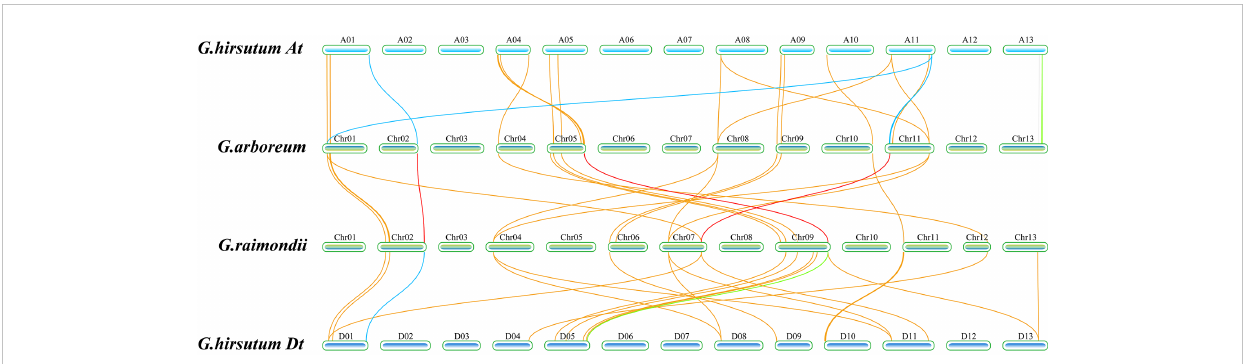
FIGURE 3 Schematic diagram of collinear analysis of the TPS family genes of G. hirsutum A/D subgroup and G. arboreum and G. raimondii , respectively. The blue squares represented the chromosome of G. hirsutum , the At subgroup of G. hirsutum was at the top, and the Dt subgroup of G. hirsutum was at the bottom. In the fi gure, the green squares represented the chromosomes of G. arboreum and G. raimondii , and the length represents the length of the chromosome. The name of the chromosome was labeled above each chromosome. The lines in the fi gure represented collinear relationships between species. The yellow lines represented collinear relationships between G. hirsutum and both G. arboreum and G. raimondii , the red lines represented collinear relationships of GhCDNs between G. arboreum and G. raimondii , the blue lines represented collinear relationships of 12 GhCDN-A between G. hirsutum and both G.arboreum and G. raimondii , the green lines represented collinear relationships of other GhCDNs between G. hirsutum and both G.arboreum and G. raimondii , and the positions of the lines on chromosomes represented the relative positions of genes on chromosomes.